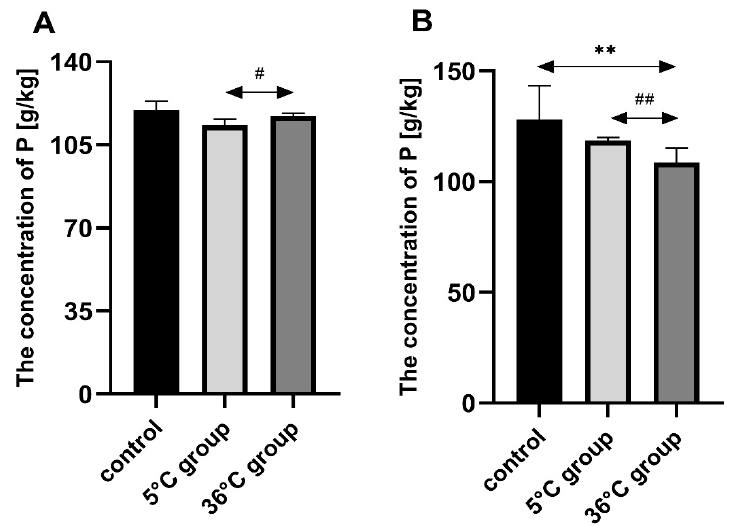
Figure 3. Bone P [g/kg] in female ( A ) and male ( B ) rats from the control group and the test groups. Rats were subjected to 4 min swimming sessions for 9 weeks in either cold water at 5 °C or at a thermally comfortable temperature of 36 °C. The first swimming session was 2 min long (day one) increasing by 0.5 min per day to 4 min (day five of the first week). The results are presented as means and standard deviations. ** p < 0.005 level of statistical significance vs. the control group (Mann–Whitney U test). # p < 0.05 level of statistical significance vs. the 5 °C group (Mann–Whitney U test). ## p < 0.005 level of statistical significance vs. the 5 °C group (Mann–Whitney U test).